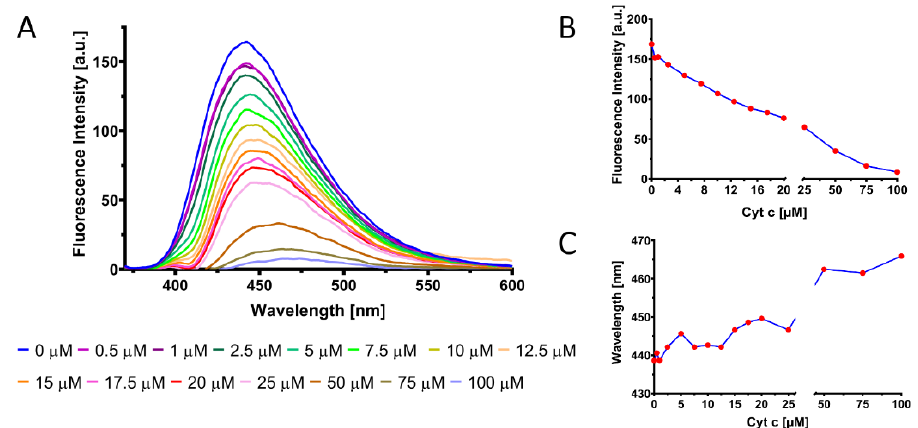
Figure 6. ( A ) Spectra showing the fluorescence intensity of CQDs in the presence of various concentrations of Cyt c. ( B ) Relationship between Cyt c concentration and CQDs maximum fluorescence intensity. ( C ) Lambda shift exhibited by the CQDs solution in the presence of various Cyt c concentrations. The quenching effect of Cyt c on fluorescence intensity of CQDs was assessed in time.